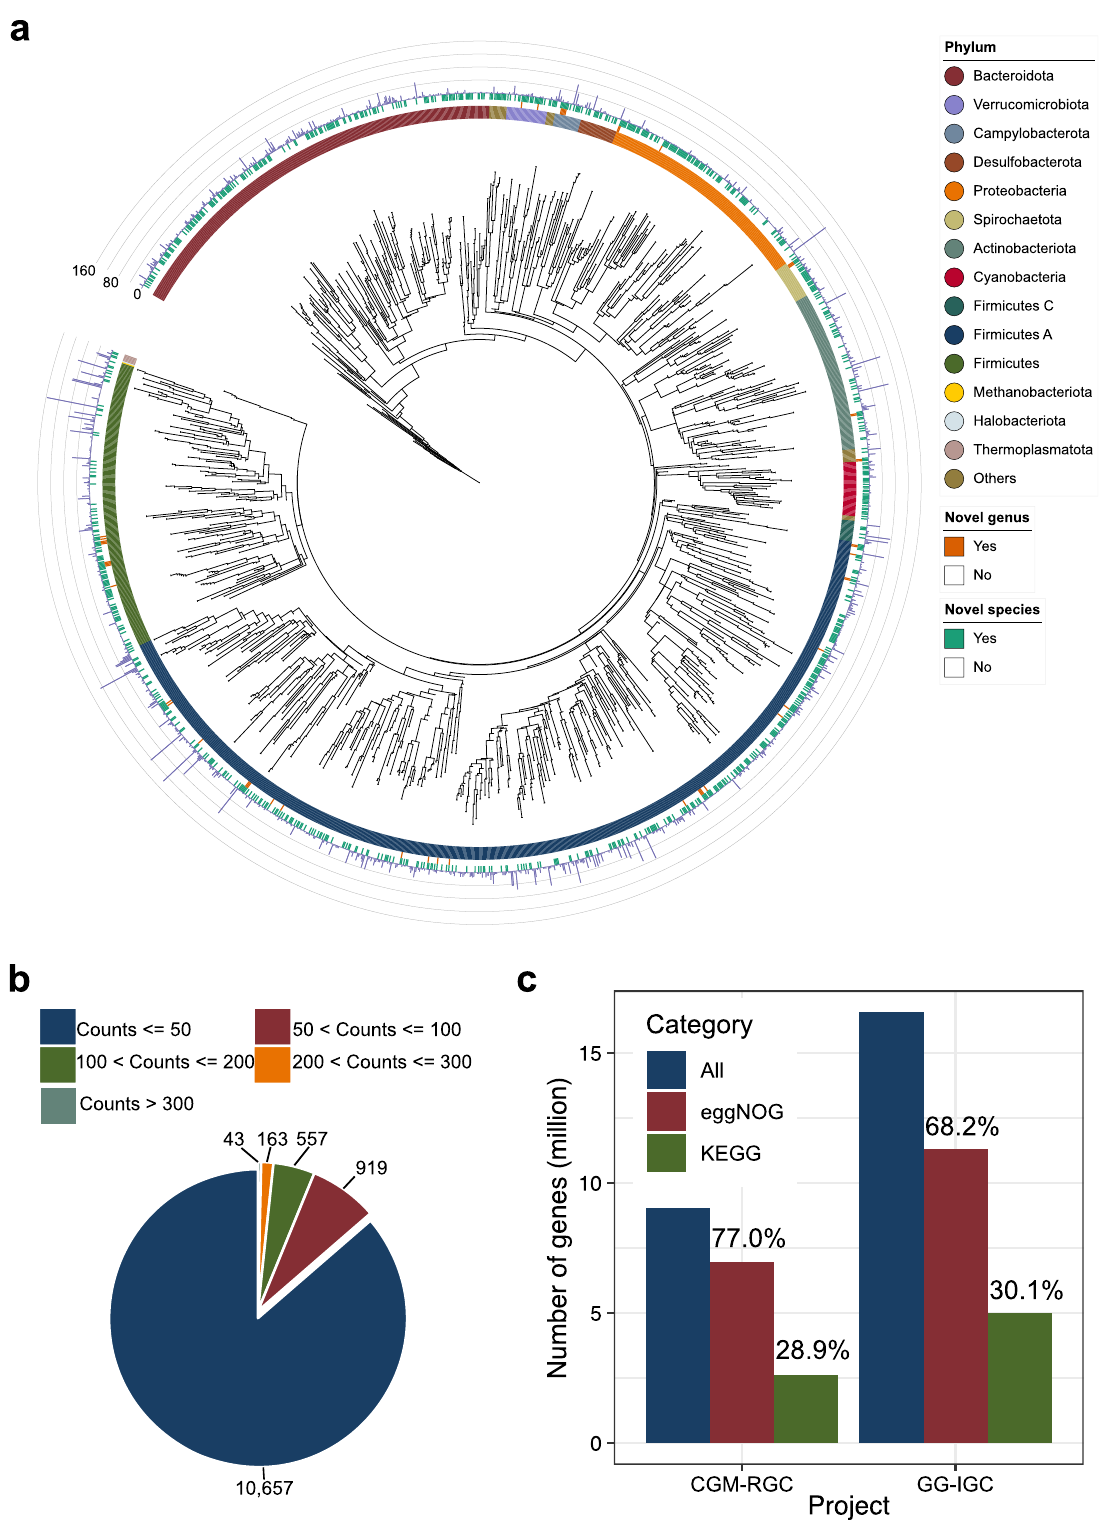
Fig. 2 Metagenome-assembled 12,339 reference genomes and 16,565,684 nonredundant genes from 799 chicken gut microbiomes. a Phylogenetic tree of 1970 bacterial and eight archaeal species. The taxonomies of the MAGs were assigned by GTDB-Tk. From the inner to outer rings, the fi rst ring represents the phyla, the second ring represents the novel species ( n = 893), the third ring represents the novel genera ( n = 38), and the height of each bar in the fourth ring represents the number of strain-level genomes in each species. b Distribution of the 12,339 MAGs among gut samples with the criteria of over 1× coverage. For example, 919 MAGs were present in samples with counts between 50 and 100. c Number of genes annotated by eggNOG and KEGG in the CGM-RGC and GG-IGC. The CGM-RGC is a previously published microbial gene catalog of the chicken gut microbiome 7 . The GG-IGC is the integrated microbial gene catalog produced in the present